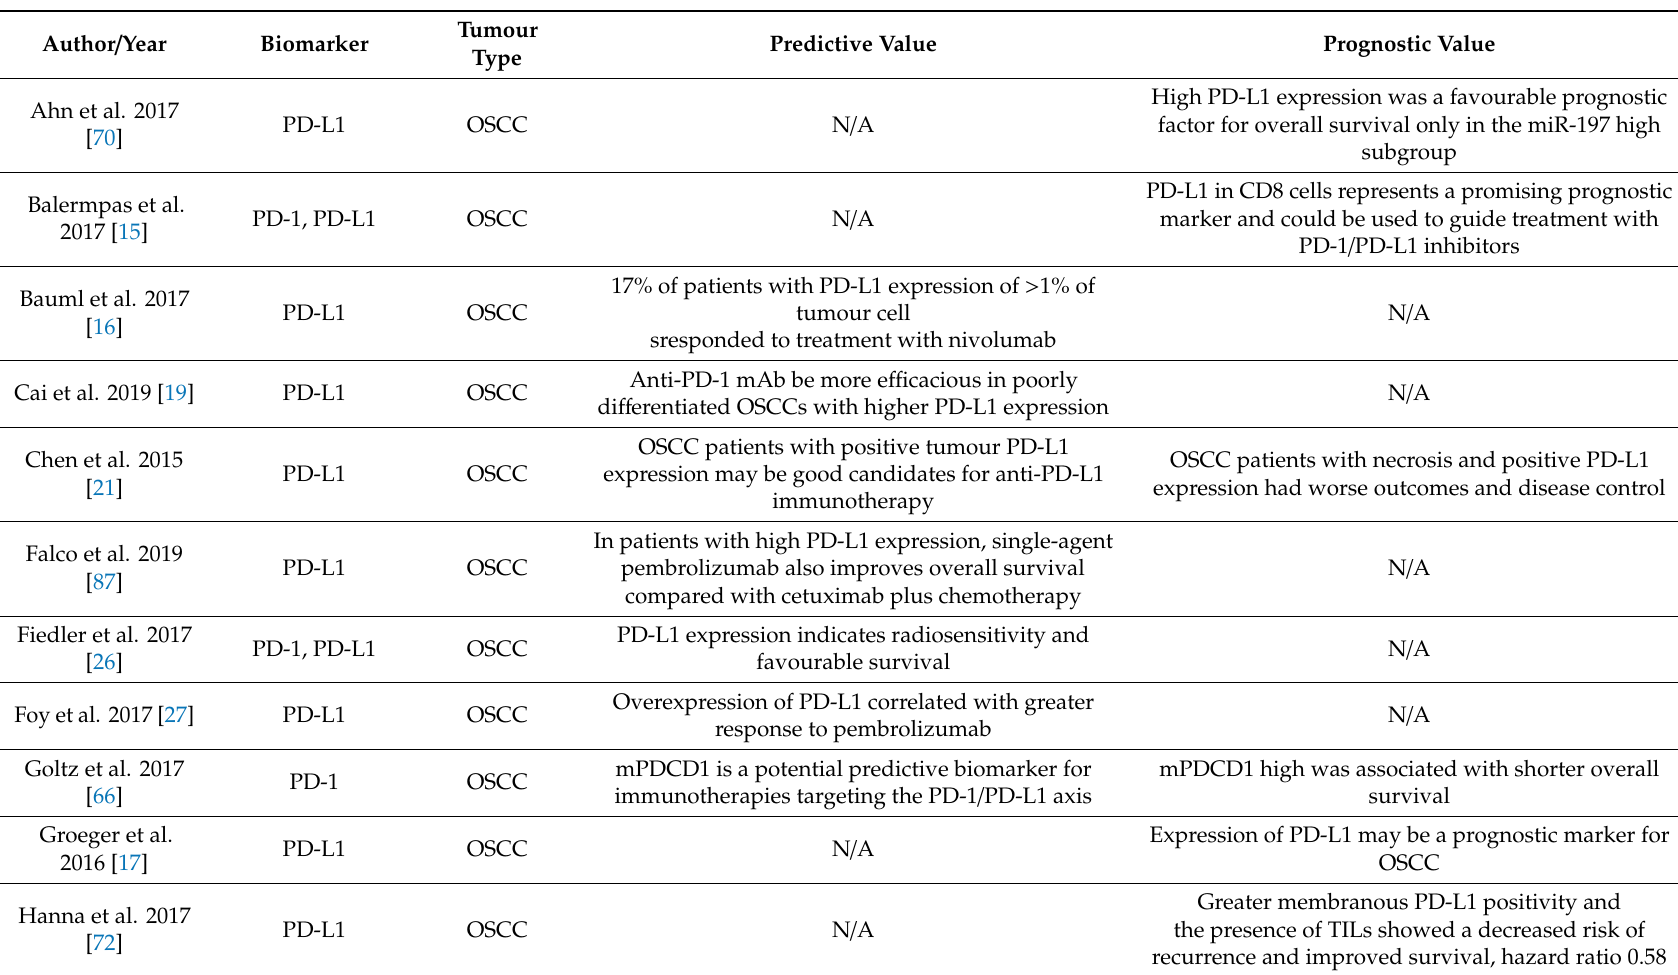
Table 4. Predictive and Prognostic Values of Immune Checkpoint Biomarkers in Relevant Included